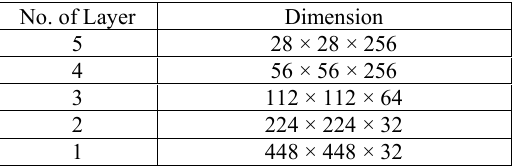
Table 2. The dimensions of each layer in the decoder.